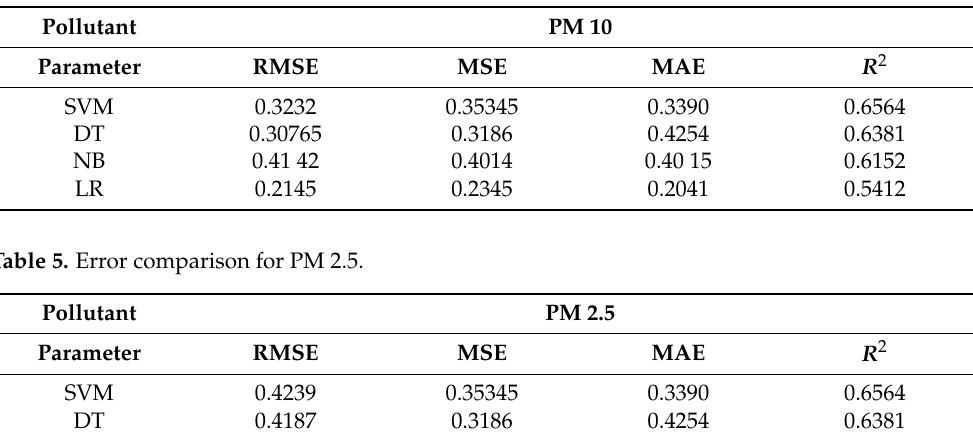
Figure 9. Performance metrics values for Machine learning models ( a ) The diamond marks indicate the RMSE and MAE values for iteration numbers in the entire marked area. ( b ) The star marks indicate appropriate MSE and R 2 values for proper iteration values. Table 4. Error comparison for PM 10.